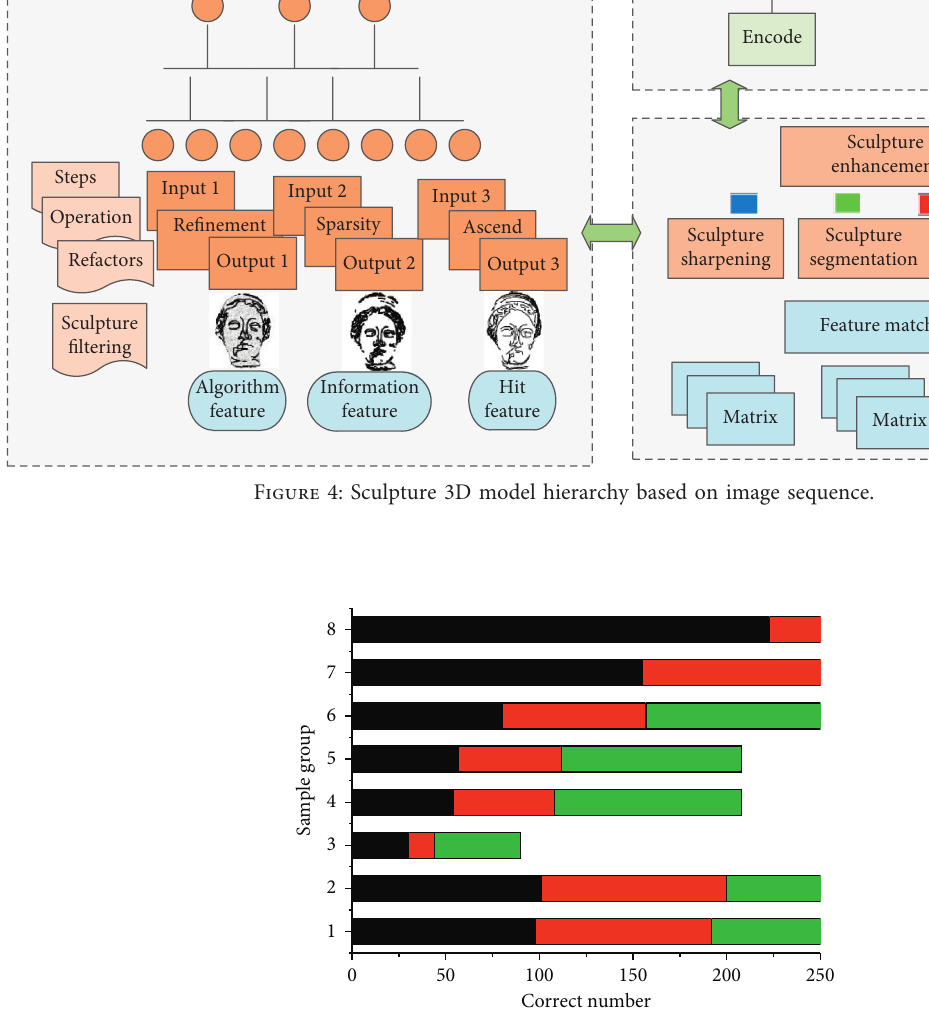
Figure 5: The distribution of the correct rate of image sequences in different experimental